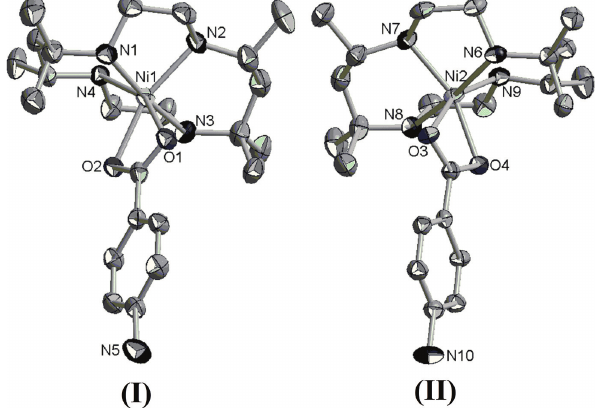
Table 2: Fractional atomic coordinates and isotropic or equivalent isotropic displacement parameters (Å 2